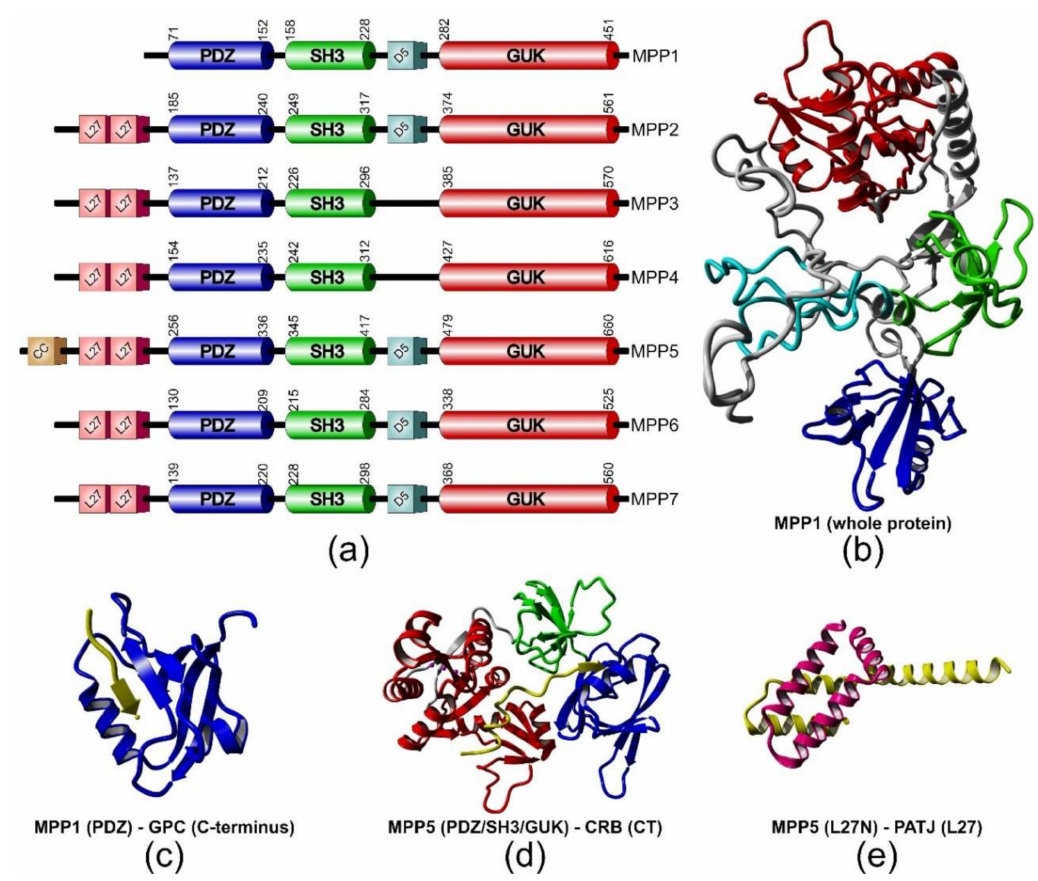
Figure 1. Structural features of membrane palmitoylated proteins (MPPs). ( a ) Schematic representation of domain structure of MPPs. The boundaries of the three canonical domains (cylinders) were estimated according to the UniProt database (www.uniprot.org). ( b ) Model of three-dimensional structure of MPP1 built with the I-TASSER web server [43]. Color code corresponds to the domains depicted in ( a ). Examples of complexes formed by MPPs with their partner proteins / protein fragments (in yellow); ( c ) the PDZ domain of MPP1 in complex with glycophorin C-terminal peptide (PDB ID: 2EJY) [44]; ( d ) the MPP5 PDZ / SH3 / GUK tandem (for explanation of these abbreviations see the main text) bound